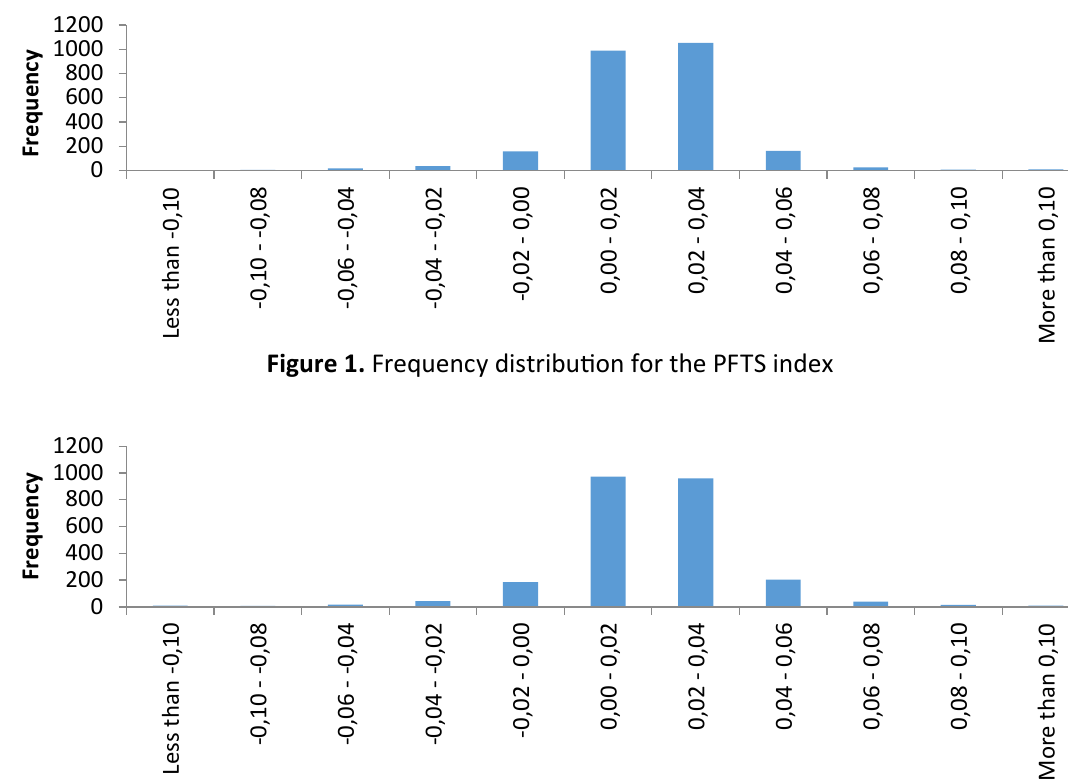
Figure 2. Frequency distribution for the UX index